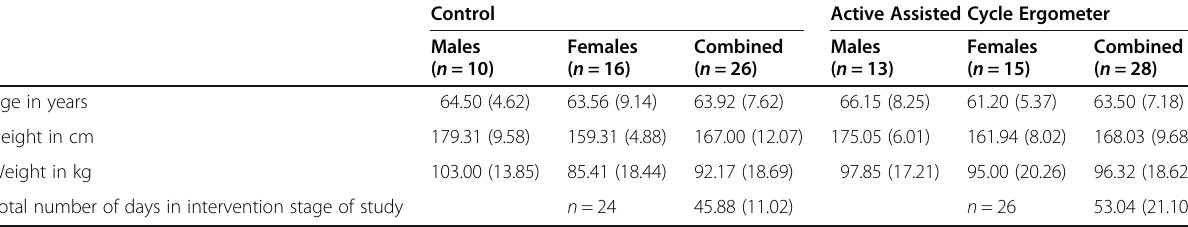
Table 1 Demographic information. Information presented as average